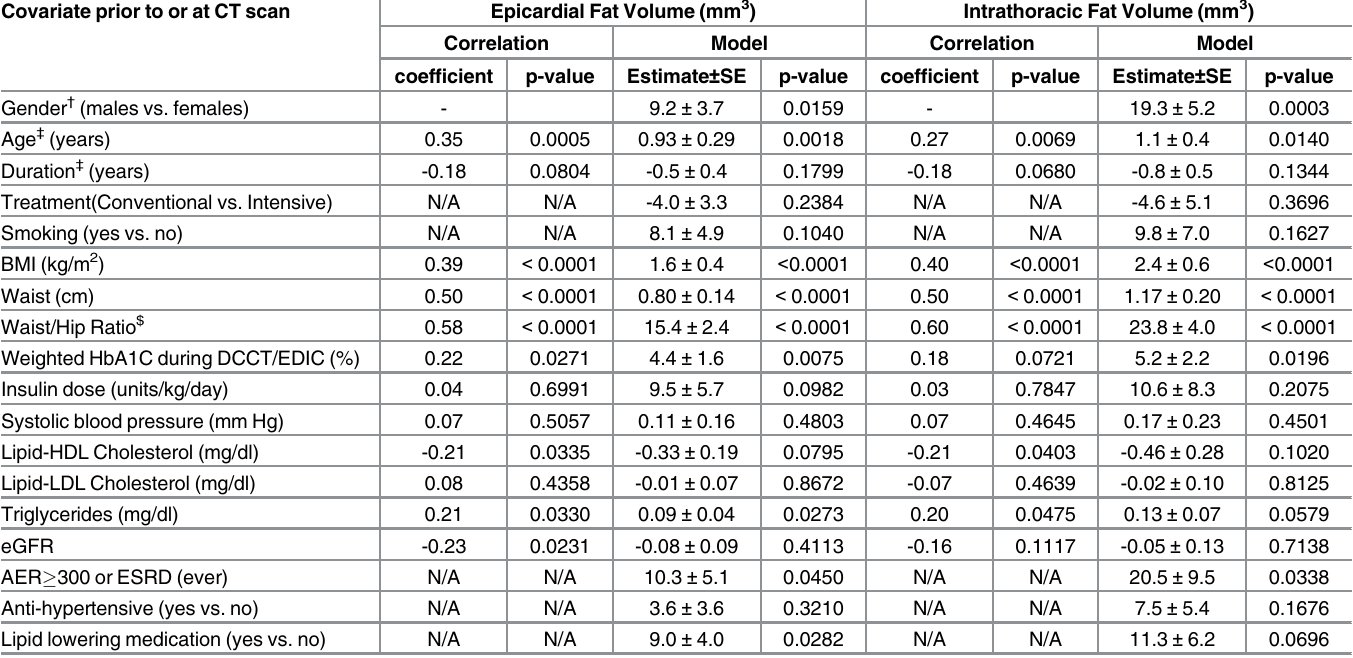
Table 2. Pearson Correlation * and Minimally Adjusted Model @ : Epicardial Fat Volume and Intrathoracic Fat Volume Associated with Selected Covariates. Covariate prior to or at CT scan